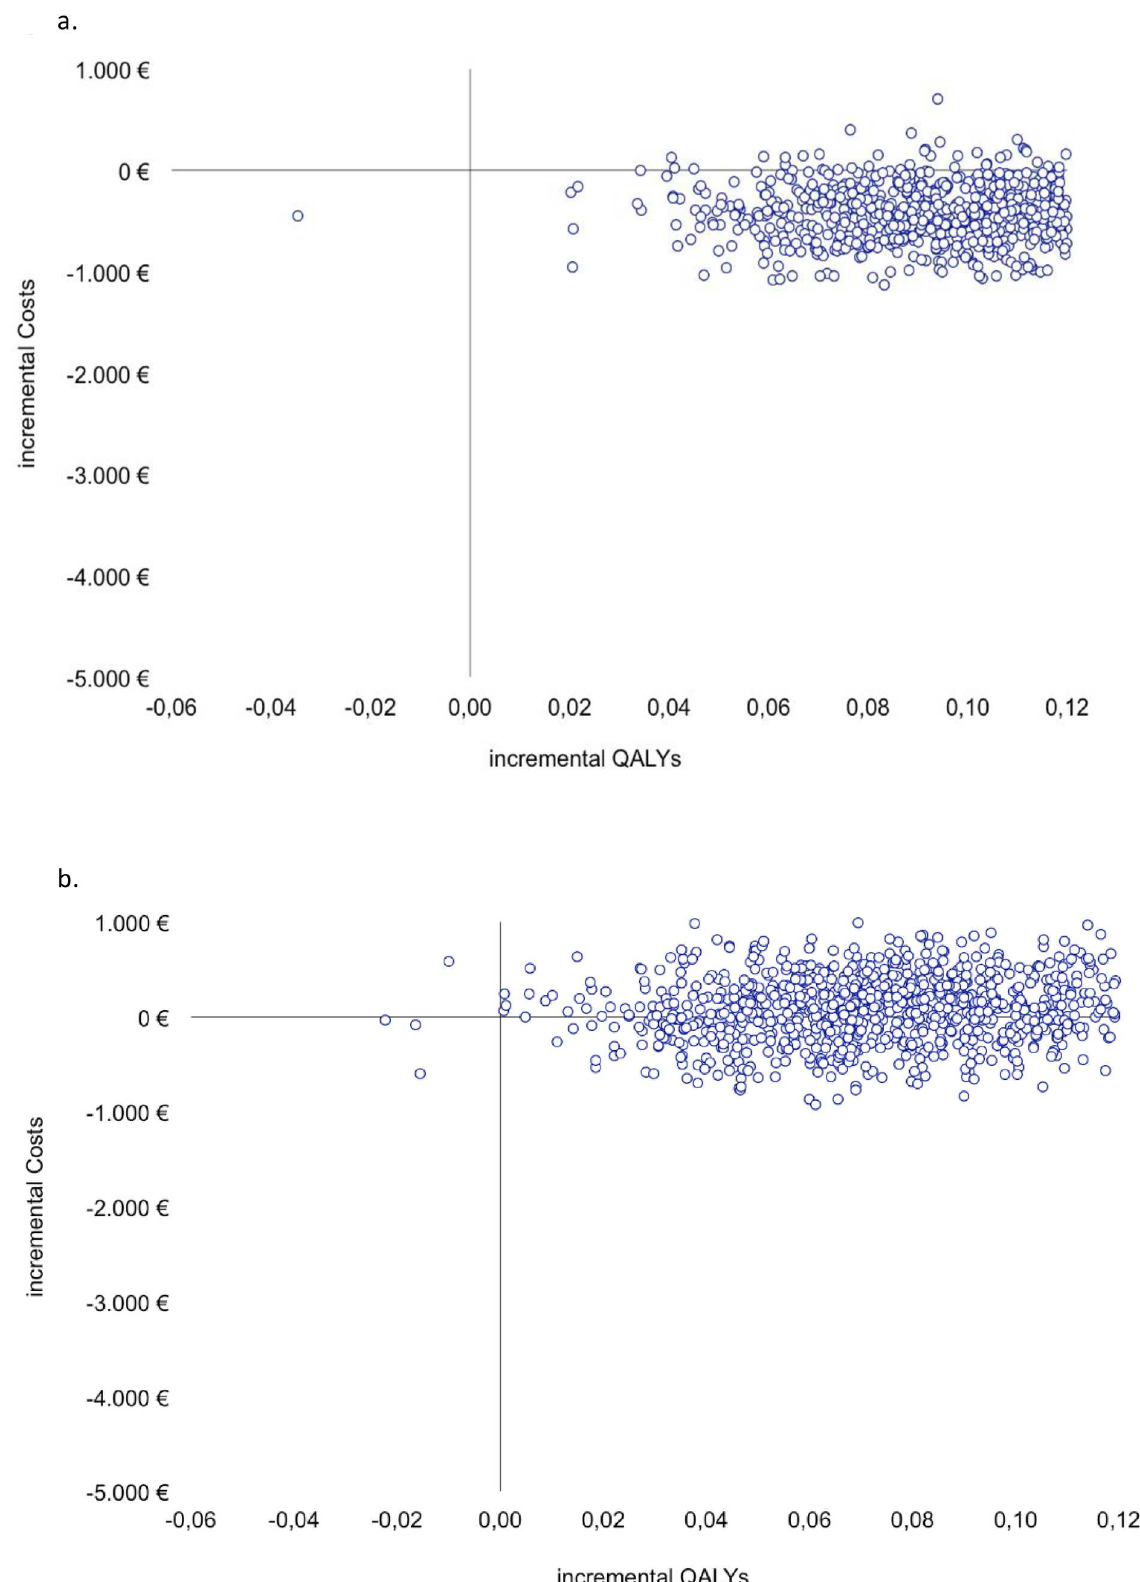
Fig 2. Cost-utility planes. Fig 2a. Scatterplot TSG vs. iTAU. Fig 2b. Scatterplot LITG vs. iTAU. QALY: quality-adjusted life year.